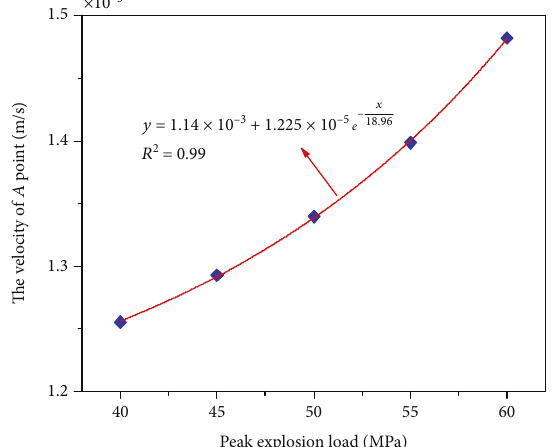
Figure 9: The relationship between the velocity change of point A and the explosion